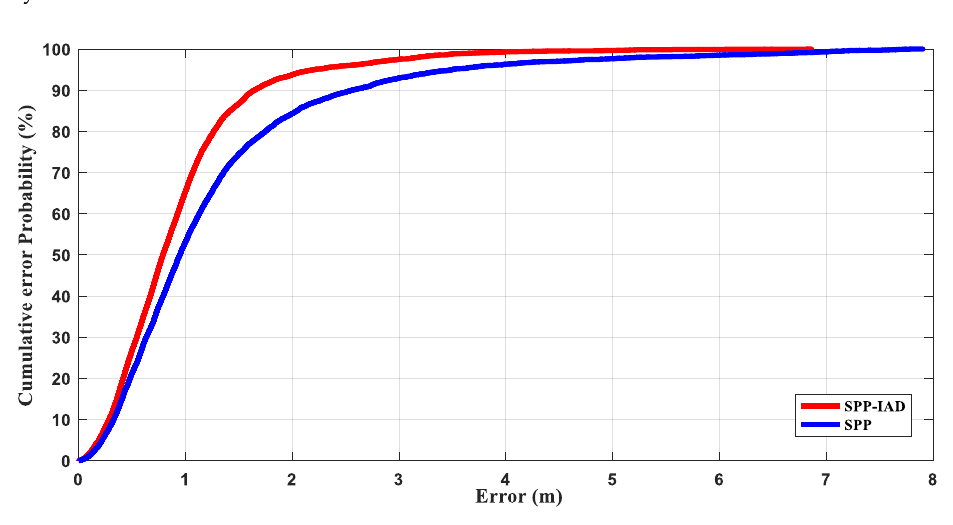
Figure 17. Cumulative probability distribution of positioning errors related to single point positioning with identification and discarding (SPP-IAD) and single point positioning (SPP).